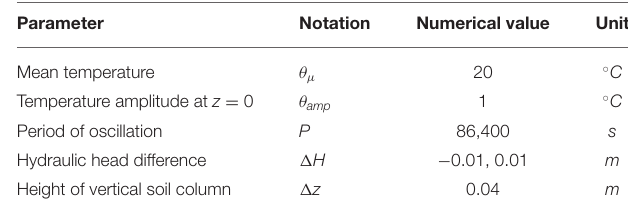
TABLE 3 | Numerical values for variables in analytical